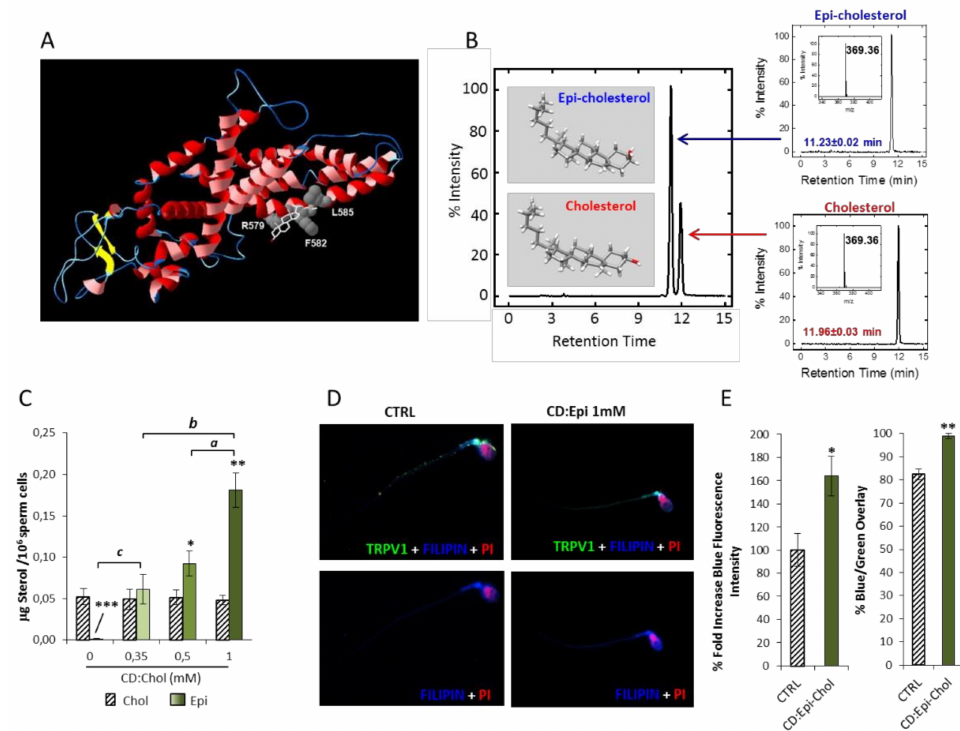
Figure 3. Computational modelling of TRPV1–cholesterol interaction and experimental addition of epicholesterol onto sperm membrane with cyclodextrin approach. ( A ) Representative image of the interaction between TRPV1 (red ribbon structure) and cholesterol (white sticks structure) at computational modeling. Major amino acids expected to be involved in molecular binding are reported as balls side chains and marked with their initials and position. ( B ) Representative images of ultrahigh performance liquid chromatography-mass spectrometry (UPLC-MS) analysis of cholesterol (Chol) and epicholesterol (Epi-Chol) content in naïve sperm cells (CTRL) incubated with complex between 2-hydroxypropyl-ß-cyclodextrin and Epi-Chol (CD:Epi-Chol) at the concentration of 1 mM. The chromatographic peaks are flanked by representative chromatogram of Chol and Epi-Chol standards and the corresponding high-resolution MS spectra, both showing a monoisotopic mass value of 369.35 a.m.u. ( C ) UPLC-MS quantification of Chol and Epi-Chol in sperm cells incubated with CD:Epi-Chol, at concentrations ranging from 0 (CTRL) to 1 mM. Data are expressed as µ g of Chol or Epi-Chol (sterols) per 10 6 sperm cells. Significance: * = p < 0.05, ** = p < 0.01, *** = p < 0.001 vs. the corresponding Chol bar; a = p < 0.05, b = p < 0.01 and c = p < 0.001 between the indicated conditions. ( D ). Immunofluorescence staining of TRPV1 (green) and sterols, detected by Filipin II (blue), in naïve sperm cells (CTRL) and cells treated with 1 mM CD:Epi-Chol. Cell nuclei were counterstained with propidium iodide (PI, red). The upper panels show the merging of the three colors channels whilst, in the lower panel, the green channel was omitted for clarity. In ( E ) the image analysis is reported. The left plot shows the blue fluorescence staining intensity, reported as %-fold increase compared to CTRL; the right plot shows the percentage of overlay between the green (TRPV1) and the blue channels (Chol). Significance: * = p < 0.05 and ** = p < 0.01 vs.